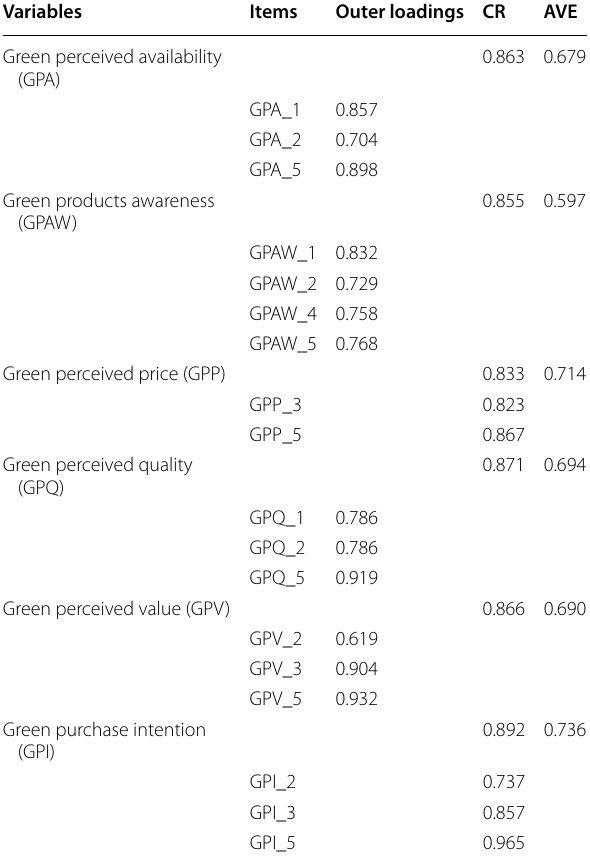
Table 2 Outer loadings, reliability analysis and